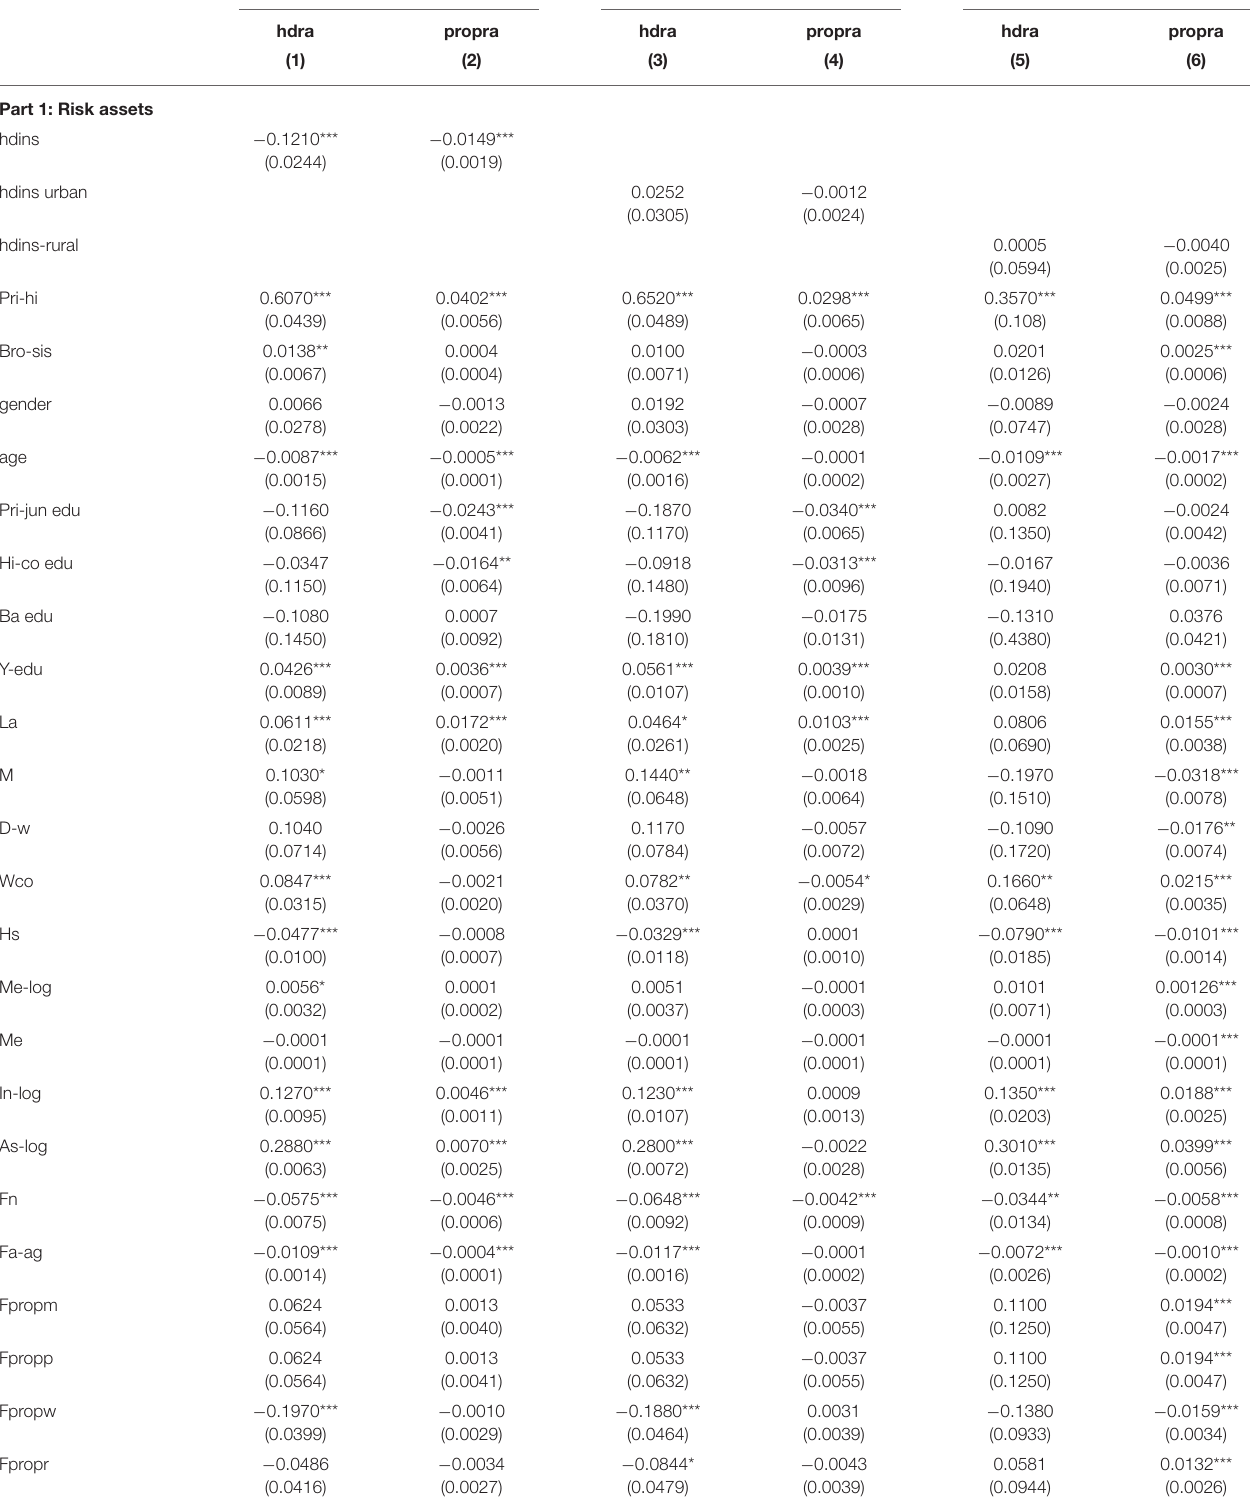
TABLE 2 | Benchmark